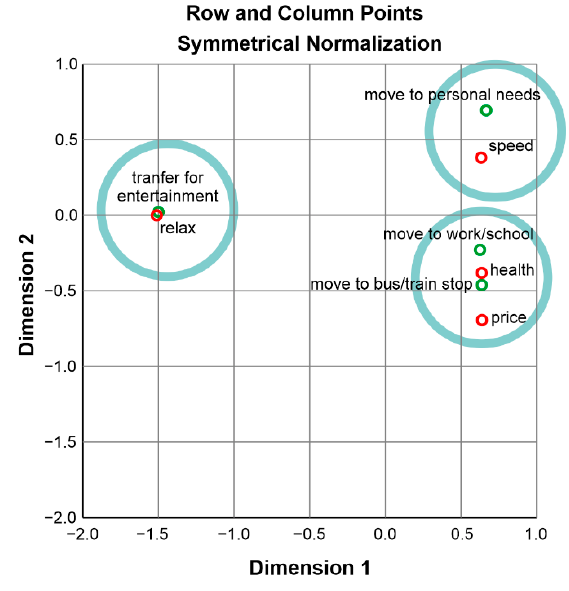
Figure 6. Correspondence map III.